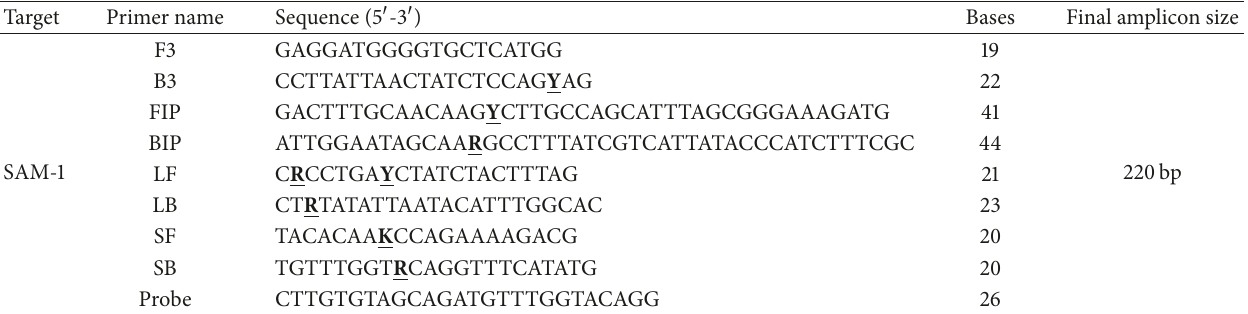
Table 1: Nucleotide sequences for Cryptosporidium hominis and parvum for stem SAM-1 LAMP test. Degenerate primers have been underlined and made